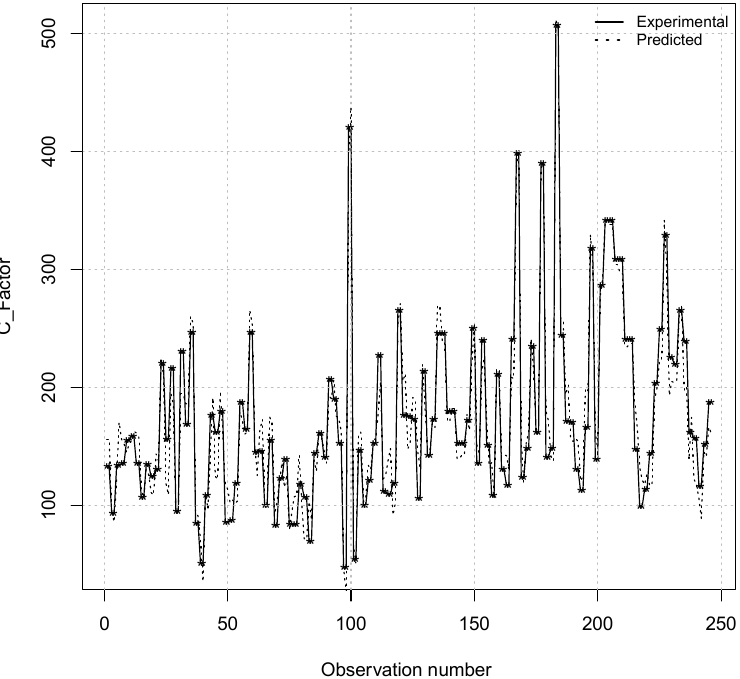
Figure 7. Comparison between the values of the Continuity Factor (C_Factor) observed experimentally and predicted by the model MARS from 245 actual observations.